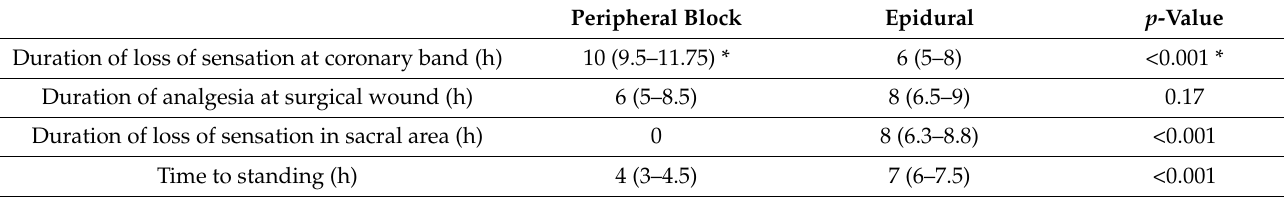
Table 3. Median duration of loss of sensation at the coronary band, median duration of analgesia at surgical wound and time to standing were compared between groups (in hours). In group P 10/12, animals had no signs of sensation at the coronary band when the area of the wound had regained sensation completely while no animal ever showed a loss of sensation at the sacral area. * The effect duration was assumed based on literature [35] as in most sheep of group P sensation at the coronary band returned after the last evaluation. On the next morning, sensation had returned in all sheep. Peripheral Block Epidural p -Value Duration of loss of sensation at coronary band (h)